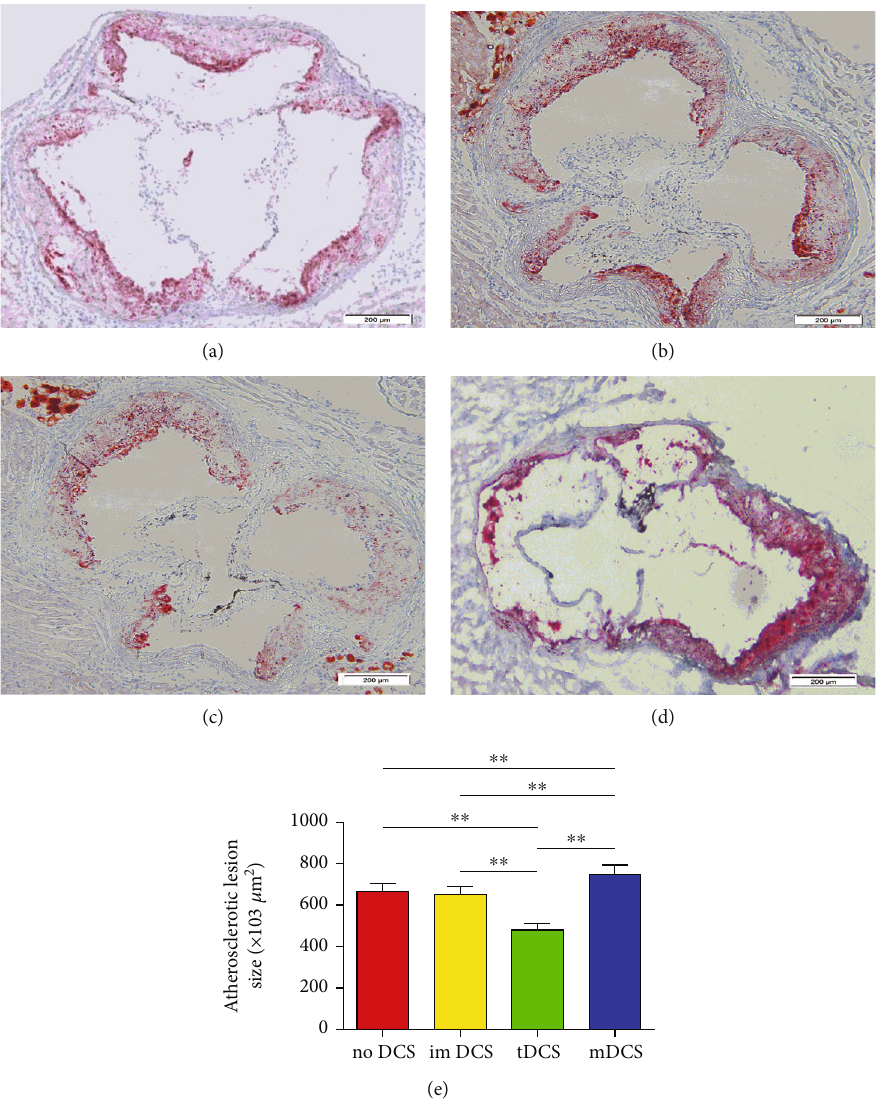
Figure 11: IL-27-tDCs ameliorate atherosclerosis in ApoE -/- mice. (a) The atherosclerotic lesion size in the no DC group. (b) The atherosclerotic lesion size in the imDC group. (c) The atherosclerotic lesion size in the IL-27-tDC group. (d) The atherosclerotic lesion size in the mDC group. (e) The atherosclerotic lesion size was counted by Image Pro. n = 6 per group. The black bar represents 100 μ m. ∗∗ P < 0 : 001